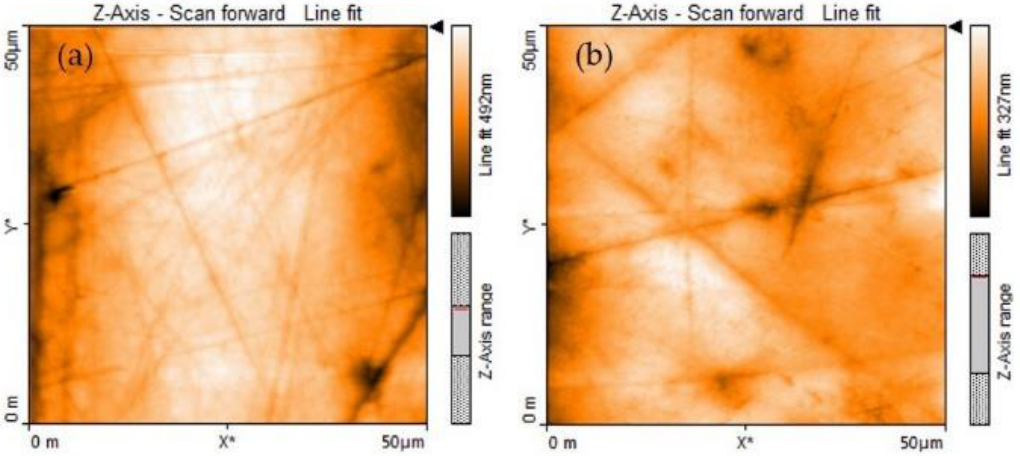
Figure 1. AFM images from dental enamel; ( a ) deciduous, ( b ) permanent. The asterisk denotes the